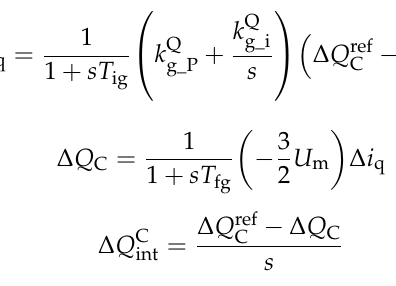
Define the Δ i q , Δ Q C , Δ Q ref , and Δ Q C are the incremental values between its current value and the initial value at operation point, respectively, and Q C is the integral of error between Q ref and Q C . Superscript ‘*’indicates reference value. GSC incremental state space